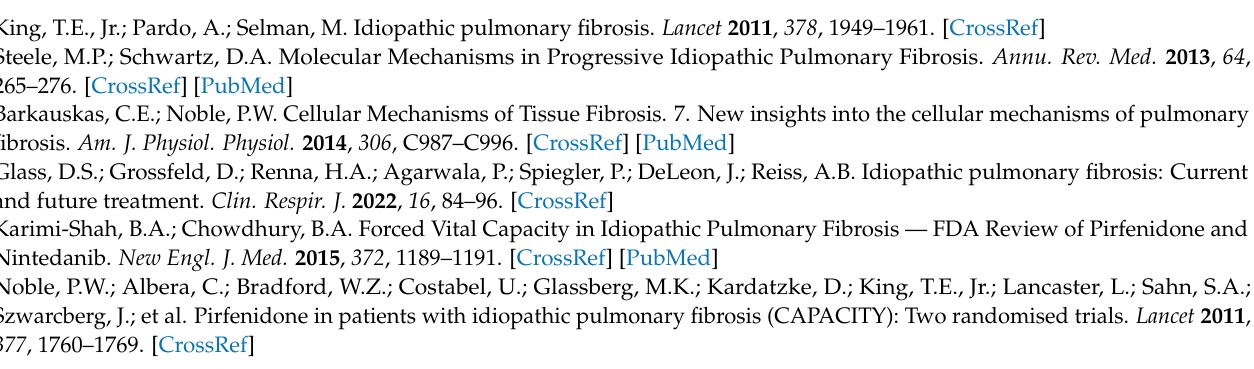
injury group; Figure S2: rFGF10 reduces hydroxyproline content; Figure S3: rFGF10 have no effect on normal lung tissue; Figure S4: rFGF10 exhibits preventive efficacy toward BLM-induced injury; Figure S5: rFGF10 exhibits therapeutic efficacy toward BLM-induced